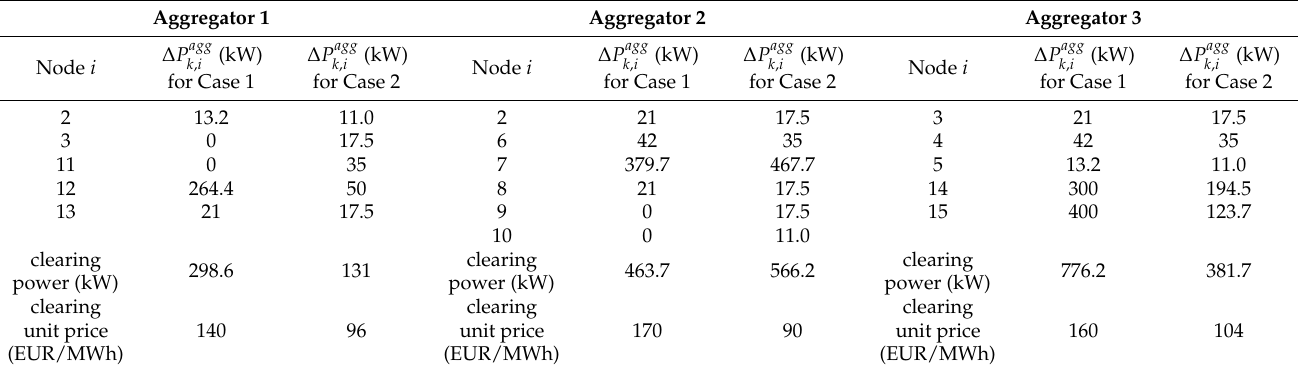
Table 5. References that the DSO sent to the aggregators.